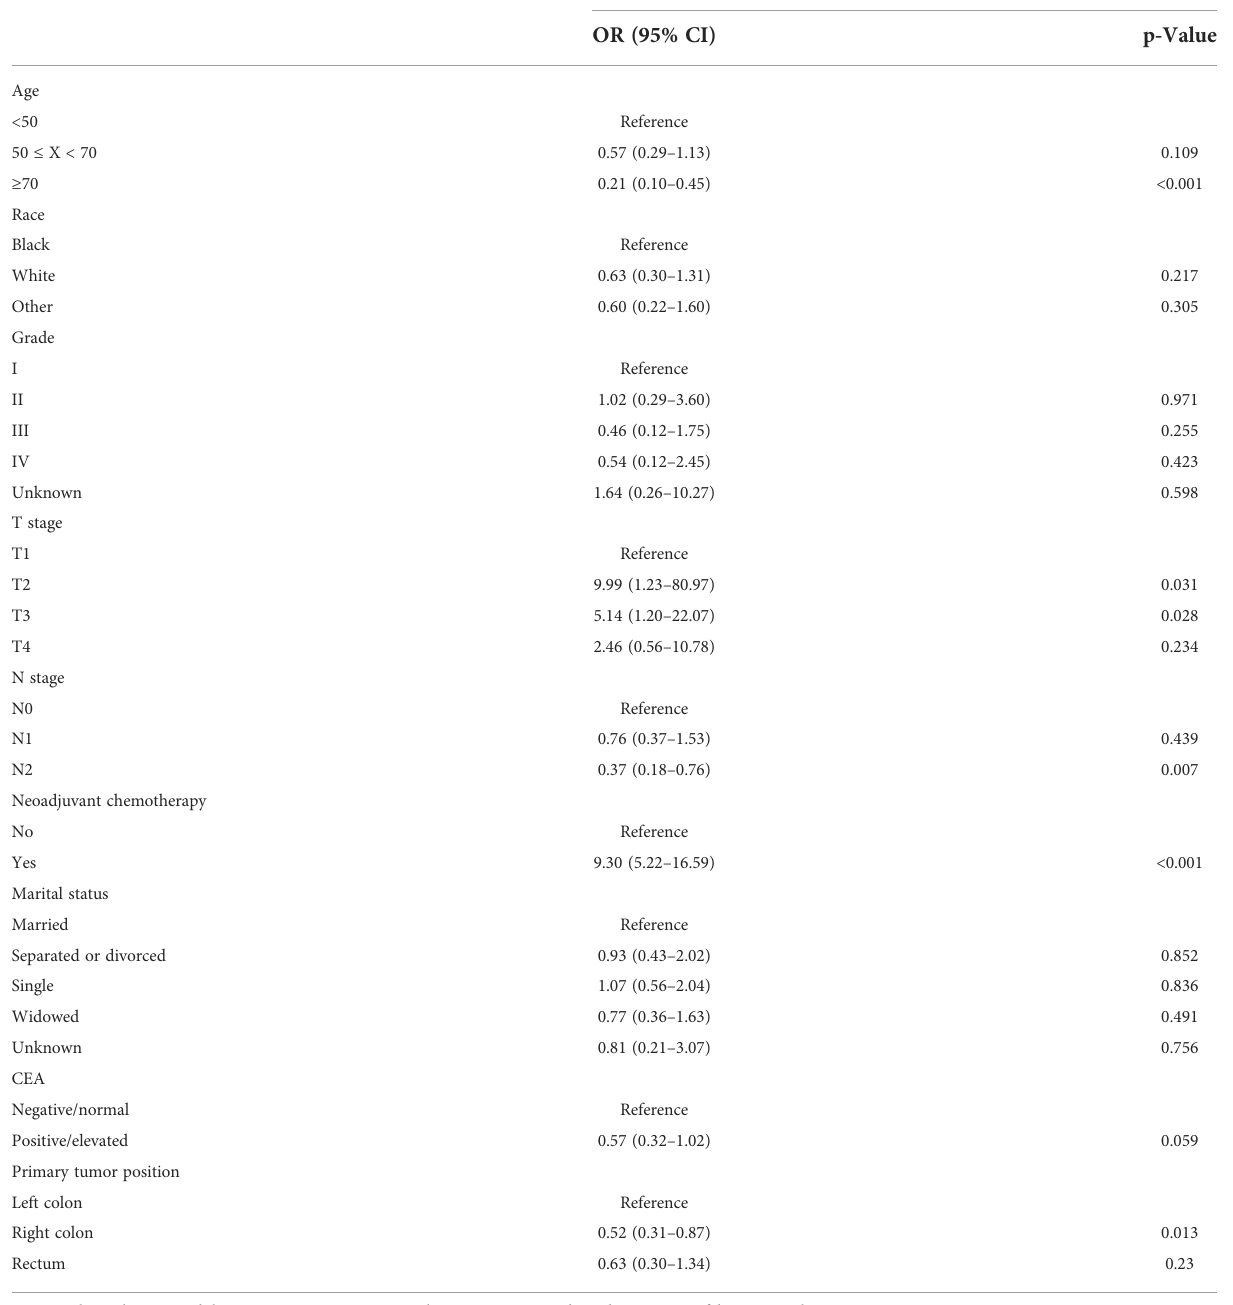
TABLE 3 Multivariate logistic analysis among M1a CRLM